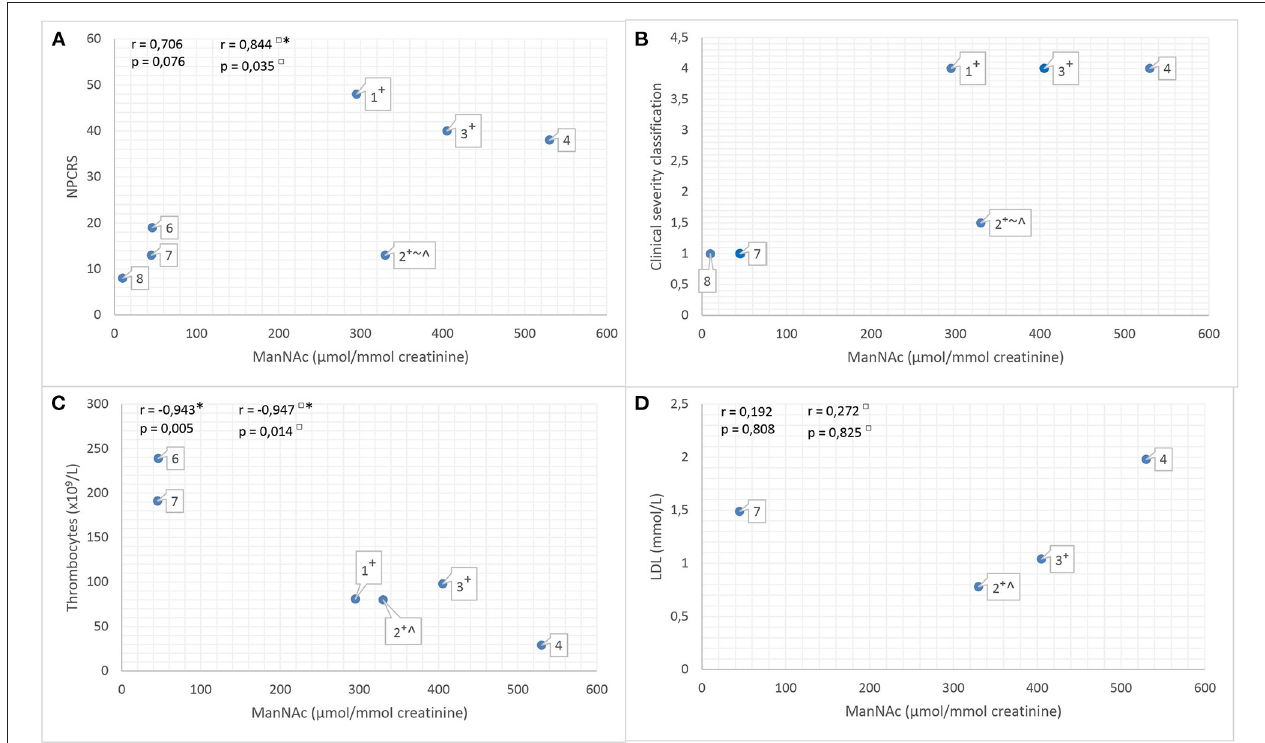
FIGURE 6 | (A) ManNAc excretion levels in urine ( µ mol/mmol creatinine, measured by 1 H NMR spectroscopy, reference value not detected) vs. the Nijmegen Pediatric CDG Rating Scale (NPCRS) for currently reported patients in whom a ManNAc excretion level was determined. (B) ManNAc excretion levels in urine ( µ mol/mmol creatinine, measured by 1 H NMR spectroscopy, reference value not detected) vs. the clinical severity classification for currently reported patients in whom a ManNAc excretion level was determined. (C) ManNAc excretion levels in urine ( µ mol/mmol creatinine, measured by 1 H NMR spectroscopy, reference value